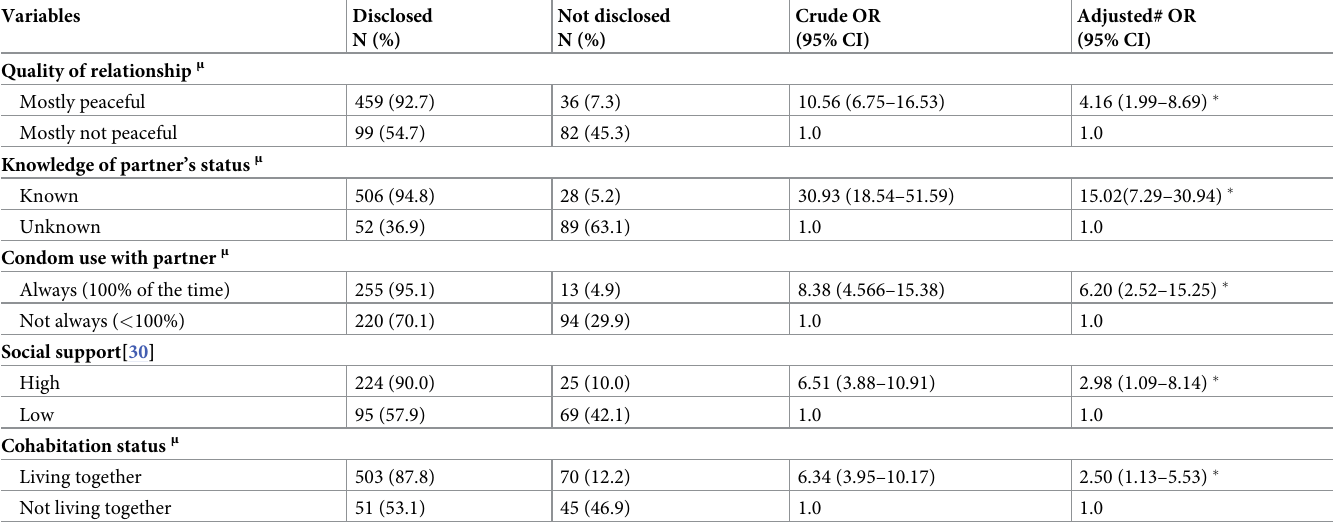
Table 6. Factors associated with HIV status disclosure to most recent sexual partner on multiple